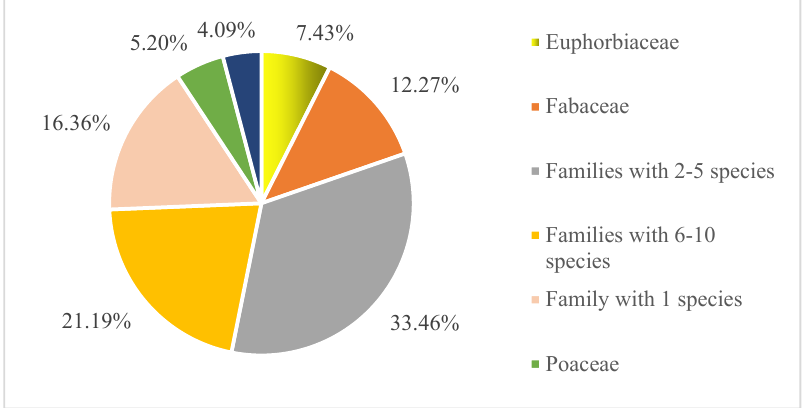
Figure 4. Species composition of the samples with rare and endangered plants in the Sanya River Basin, Hainan Province, China.